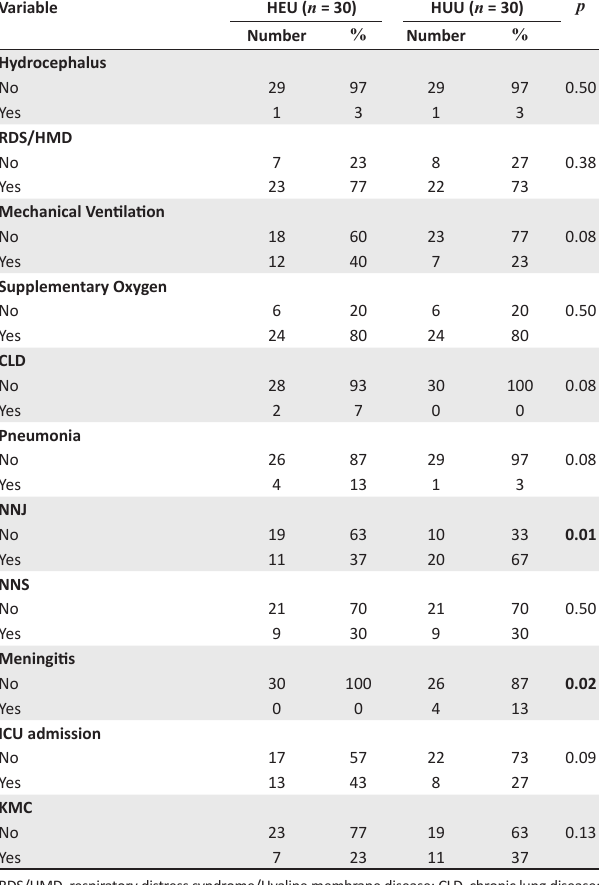
TABLE 2: Complications for human immunodeficiency virus-exposed uninfected and human immunodeficiency virus-unexposed uninfected groups. Variable